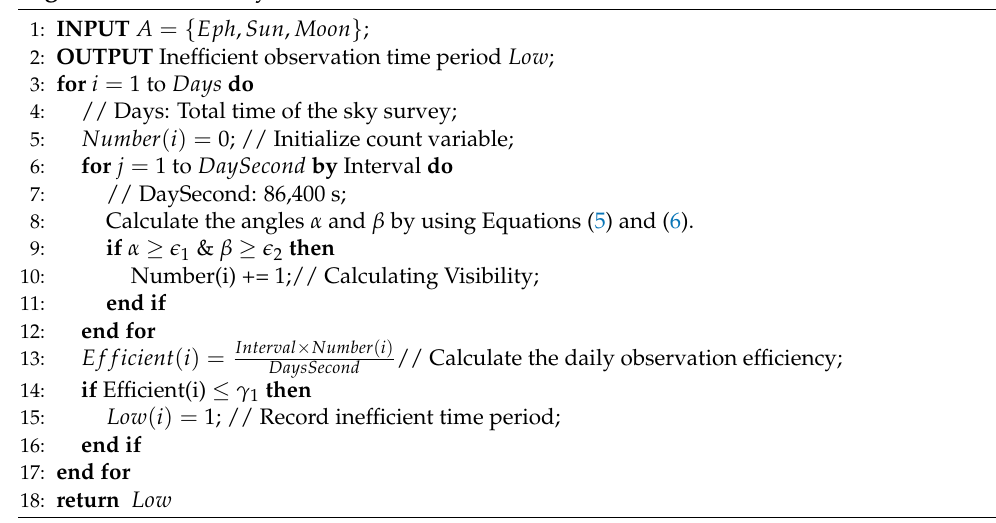
Algorithm 1 Efficiency Statistics